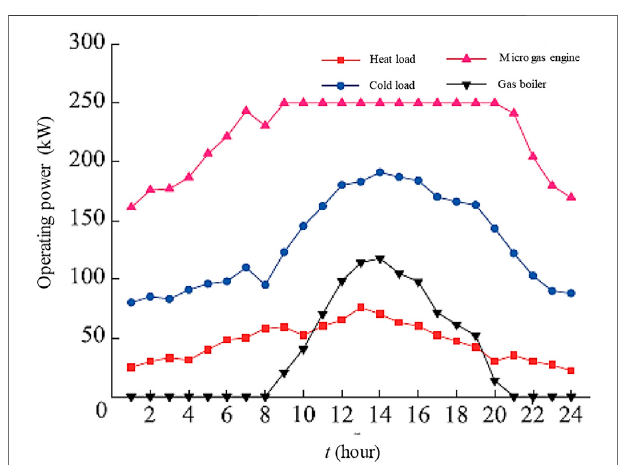
FIGURE 13 | Comparison of power optimization of the fourth